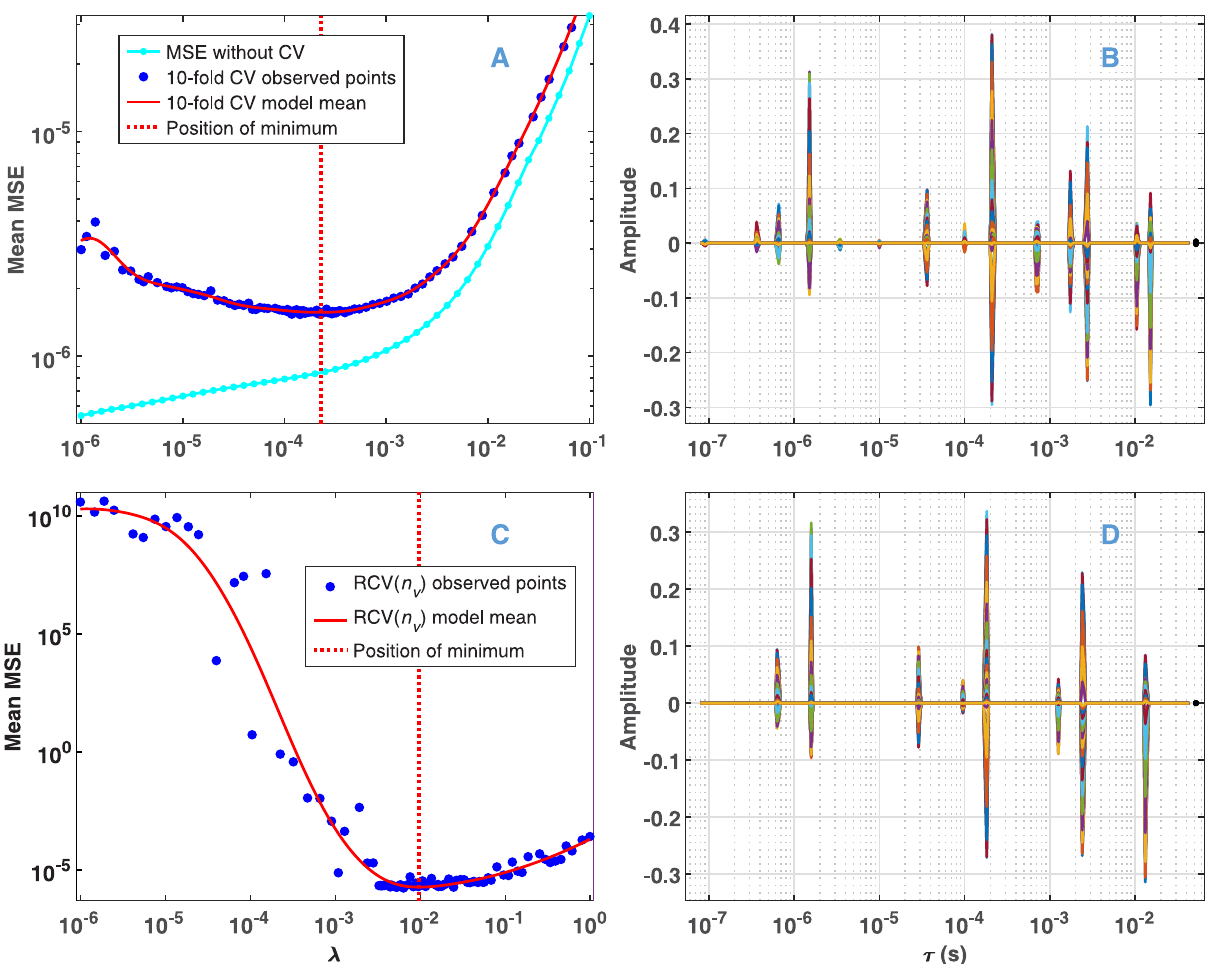
Fig 2. Model selection by BO from the simulated data presented in Fig 1C and 1D at a fixed value of ω = 1. Noise level: σ obtained without (cyan) and with 10-fold CV (blue and red). (C) Mean MSE obtained with RCV( n v ). (B) and (D) Solution of the GENP calculated with the value of λ selected at the minimum presented in (A) and (C), respectively. A line in a particular color in panel (B) and (D) corresponds to a column x � , k in Eq (8), plotted against the grid of the time constants, while the colors represent different wavelengths. (The black dot beyond the upper limit of τ corresponds to the value of τ = 1 .) The sparsity of the solution is manifested in the low number of features in the form of narrow spikes, representing single exponentials, whose time constant and amplitude are indicated by their location and height,